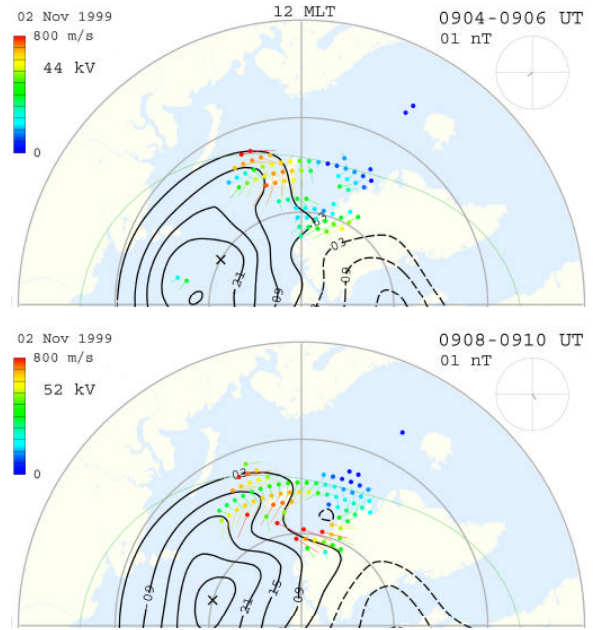
Fig. 10. The LOS velocity maps showing a flow channel in the field- of-view of the Finland radar. The radar was located near 12:00 MLT and observed the dusk convection reversal. The approximate axis of the flow channel is superposed in the first map. The 80 ◦ , 70 ◦ and 60 ◦ magnetic latitudes are shown. The cross shows the north geographic pole. The ground-scatter is shown in gray.